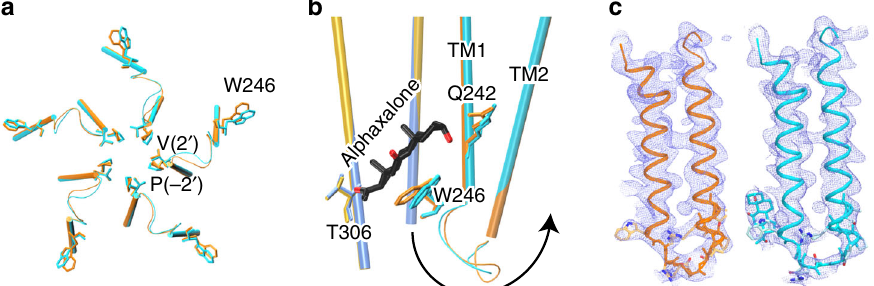
Fig. 6 Alphaxalone-induced structural changes at the bottom of the TMD. a Bottom view of overlaid TM1-TM2 structures of the apo (orange) and alphaxalone-bound (cyan) ELIC- α 1GABA A R. b Side view of overlaid structures of apo (principal subunit - gold; complementary subunit - orange) and alphaxalone-bound (principal subunit - blue; complementary subunit - cyan) ELIC- α 1GABA A R. For clarity, only TM2 and TM3 are shown in the principal subunit and only TM1 and TM2 are shown in the complementary subunit. The arrow highlights structural perturbations originating from the alphaxalone binding site near W246 through the TM1 – TM2 linker to the pore-lining residues P253 ( − 2 ′ ) and V257 (2 ′ ). c The 2 F O - F C electron density maps (blue mesh, contoured at 1 σ ) covering TM1 – TM2 in the apo (left) and alphaxalone-bound (right) ELIC- α 1GABA A R. The sidechains for residues W246 to V257 (2 ′ ) are